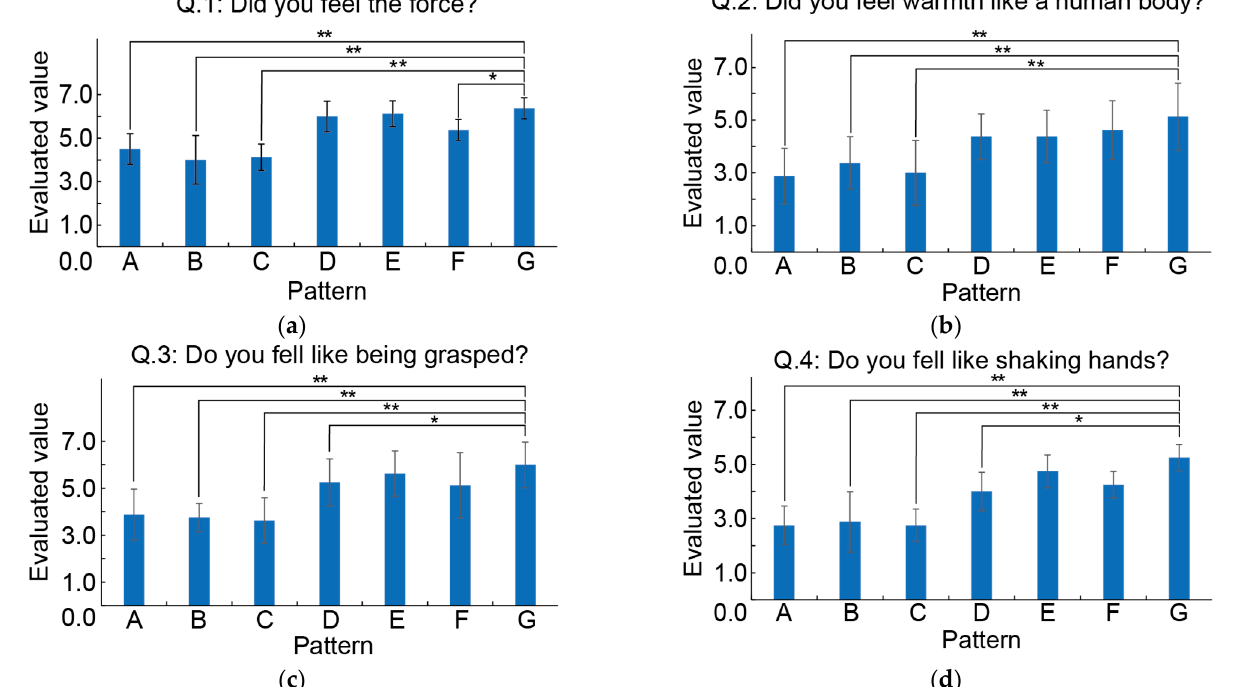
Figure 14. Answers of the participants for questionnaires: ( a ) question 1, ( b ) 2, ( c ) 3 and ( d ) 4. * 0.01 < p < 0.05, ** p <